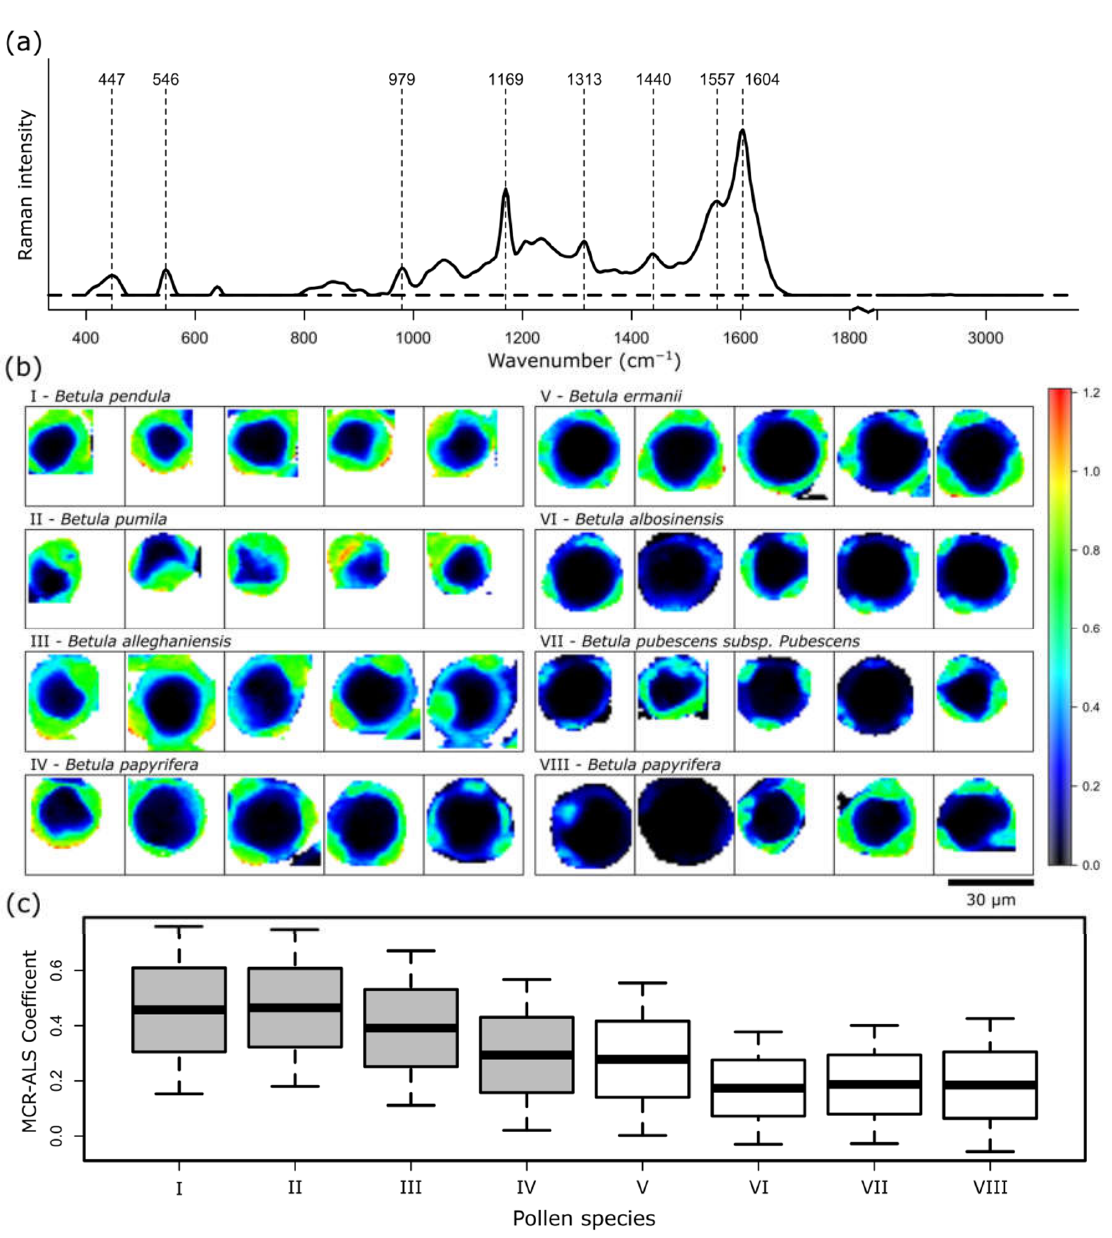
Figure 4. MCR-ALS results for the component representing sporopollenin. ( a ) Calculated spectrum, ( b ) spatial distribution and ( c ) mean concentration of the components of seven different pollen